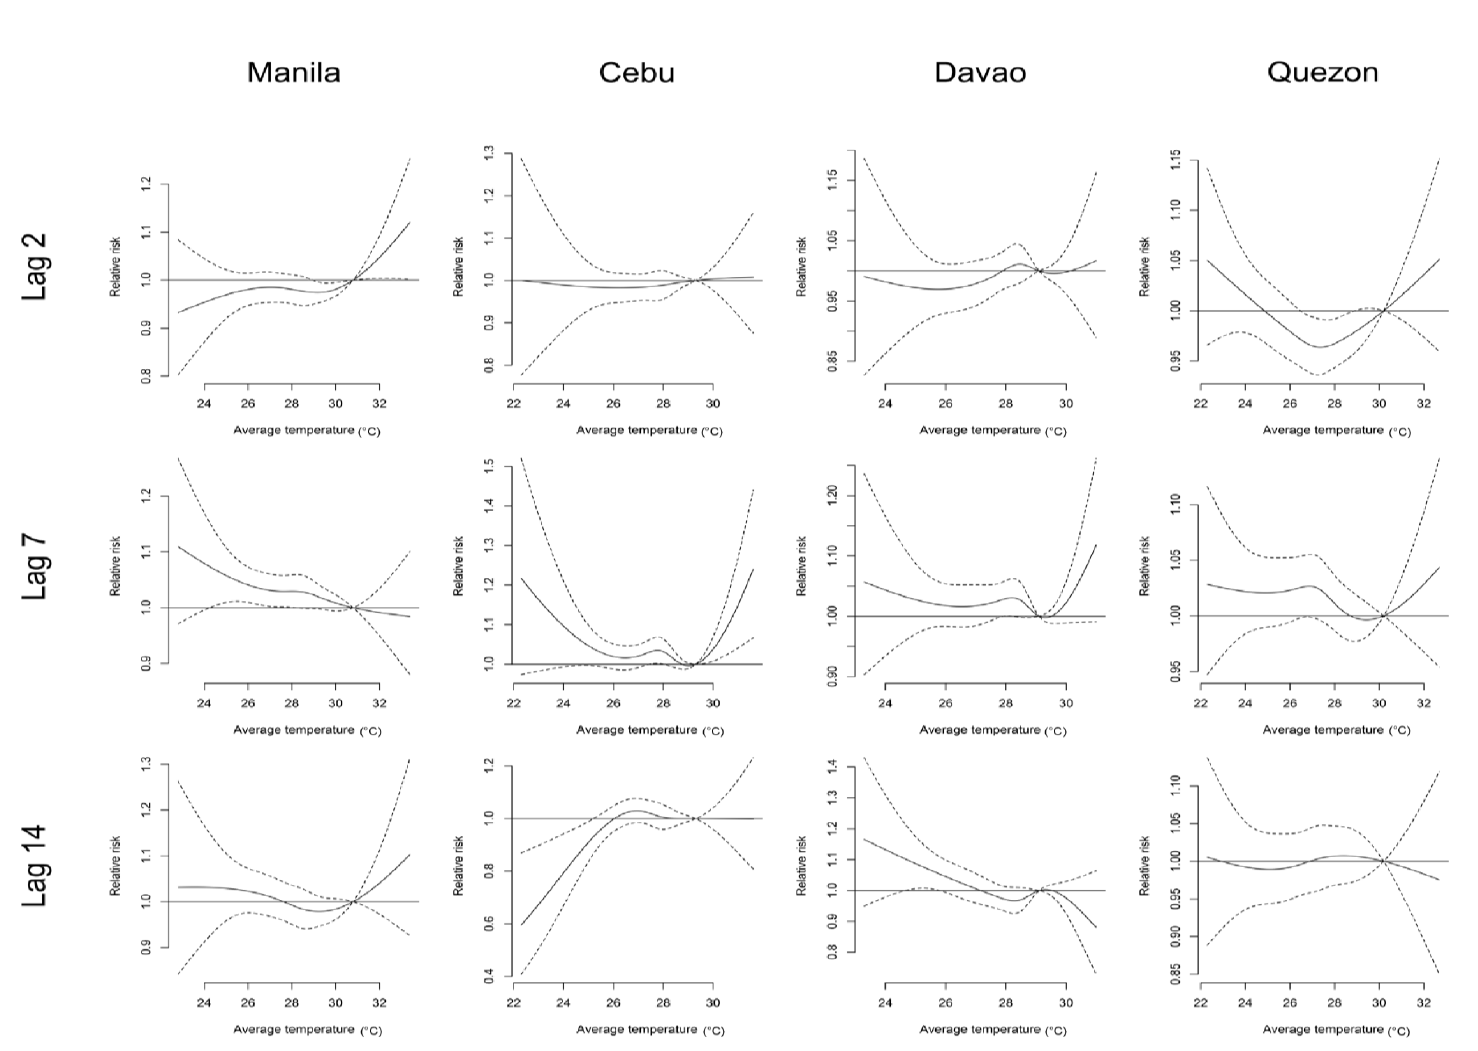
Figure 1. Diabetes mortality and temperature risk curves (centered at the 75th temperature percentile) with maximum lag 0–15 in various lag slices (at 2, 7 and 14) by city.